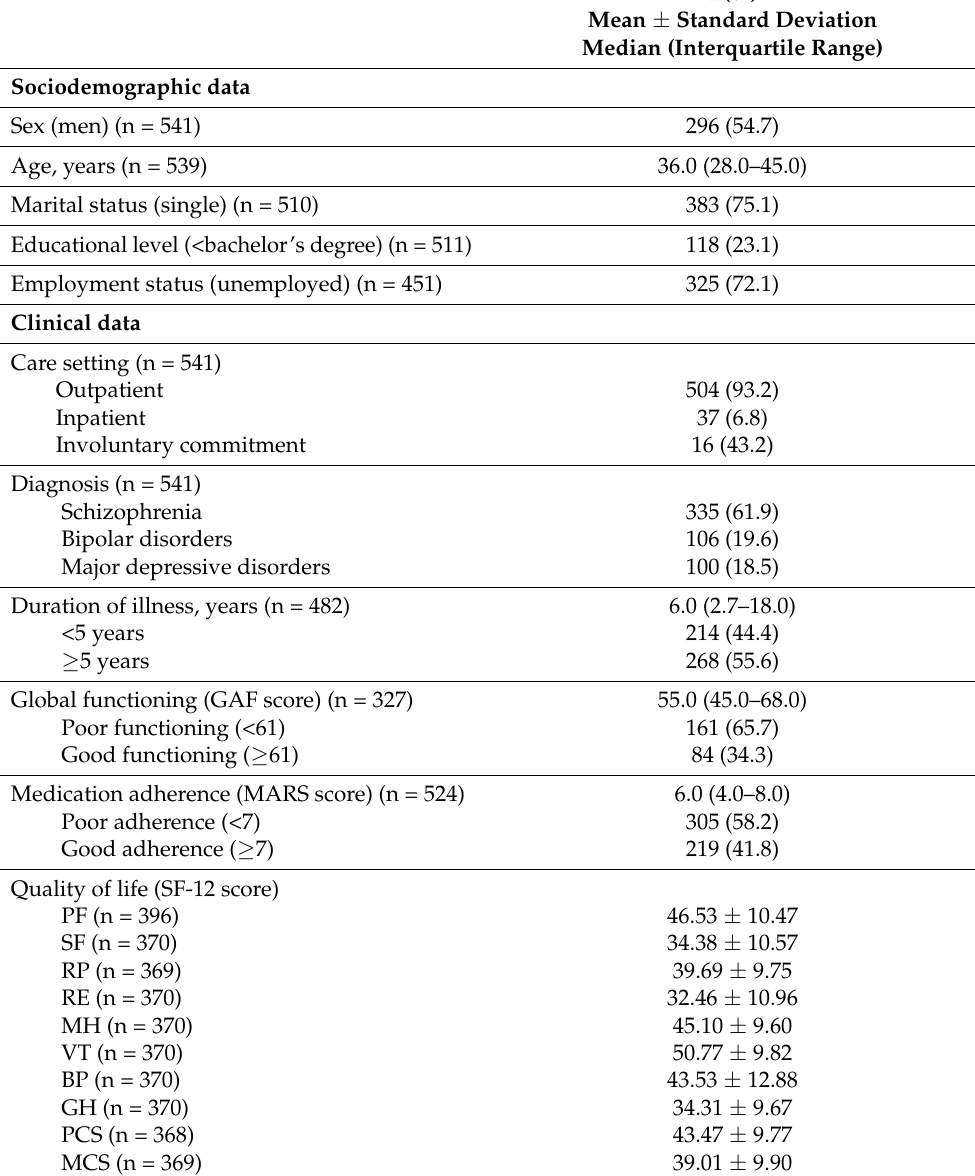
Table 1. Sample characteristics (n =